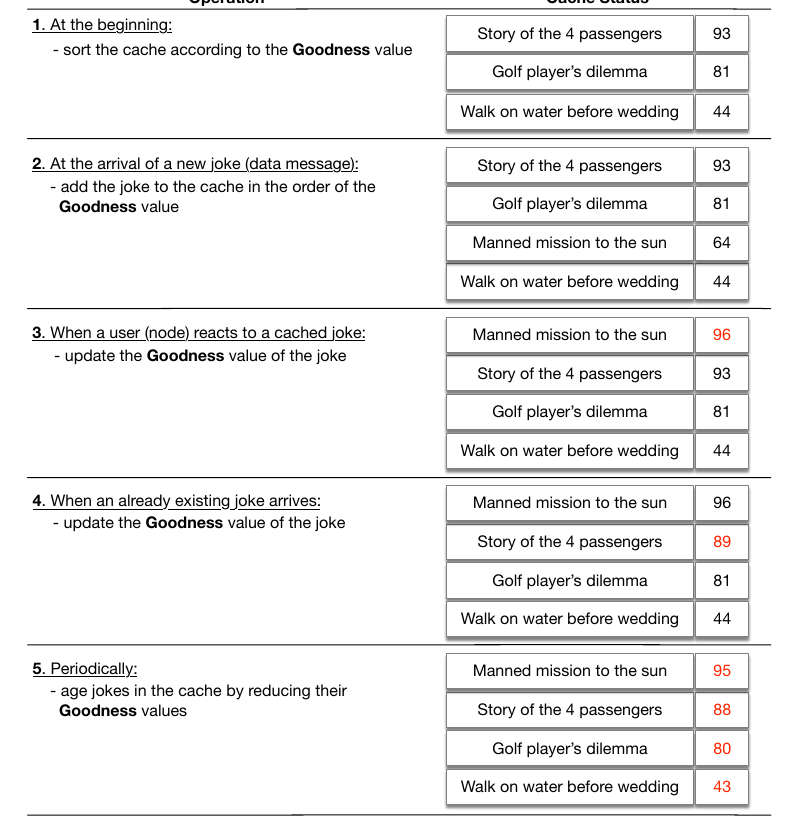
Figure A1. Data management mechanism of Keetchi.